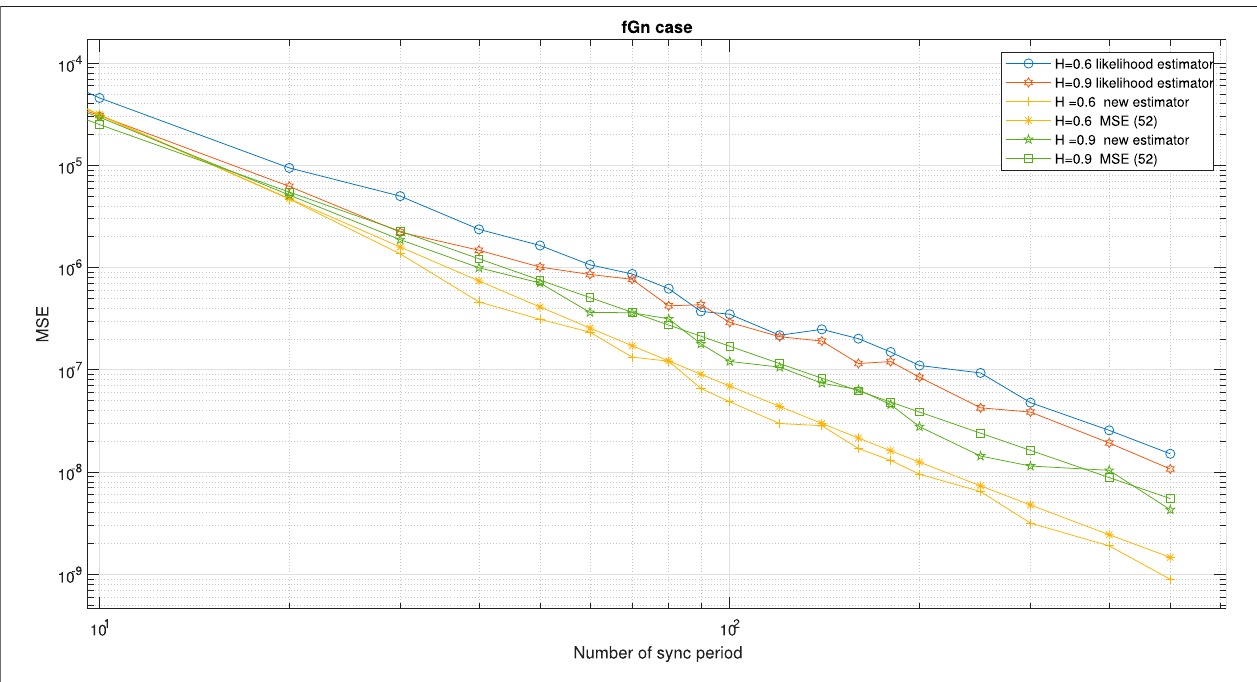
FIGURE 7 | Performance comparison between the new clock skew estimator Eq. 3 with the clock skew estimator of Noh et al. [34] denoted here as the likelihood estimator. In addition, we have the simulated performance results for our new proposed expression for the MSE Eq. 52 for the fGn case. α (cid:1) 50 ppm , Q (cid:1) 5 ms . ) , σ ω (cid:1) σ ω (cid:1) 1000 μ s , d (cid:1) 5 ms , d (cid:1) 5.5 ms . The results were obtained for 100 Monte-Carlo trails. T syn (cid:1) 15 . 6 ms ( 64 packet ms sm sec 1 2